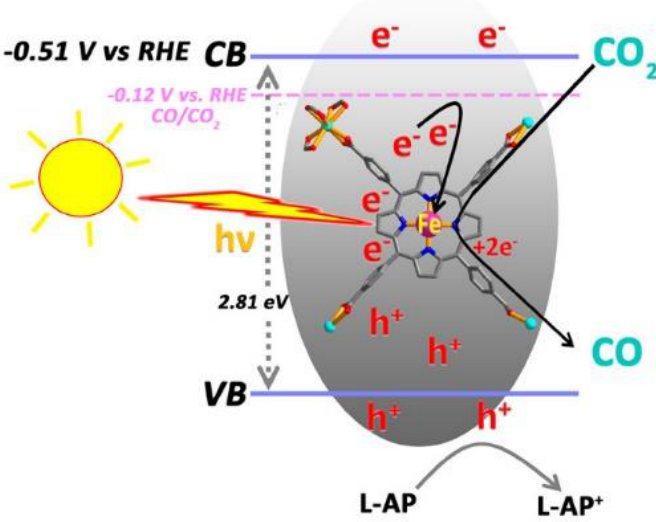
Figure 2. Schematic illustration of the indium–porphyrin framework for CO 2 conversion with high CO selectivity [49] .